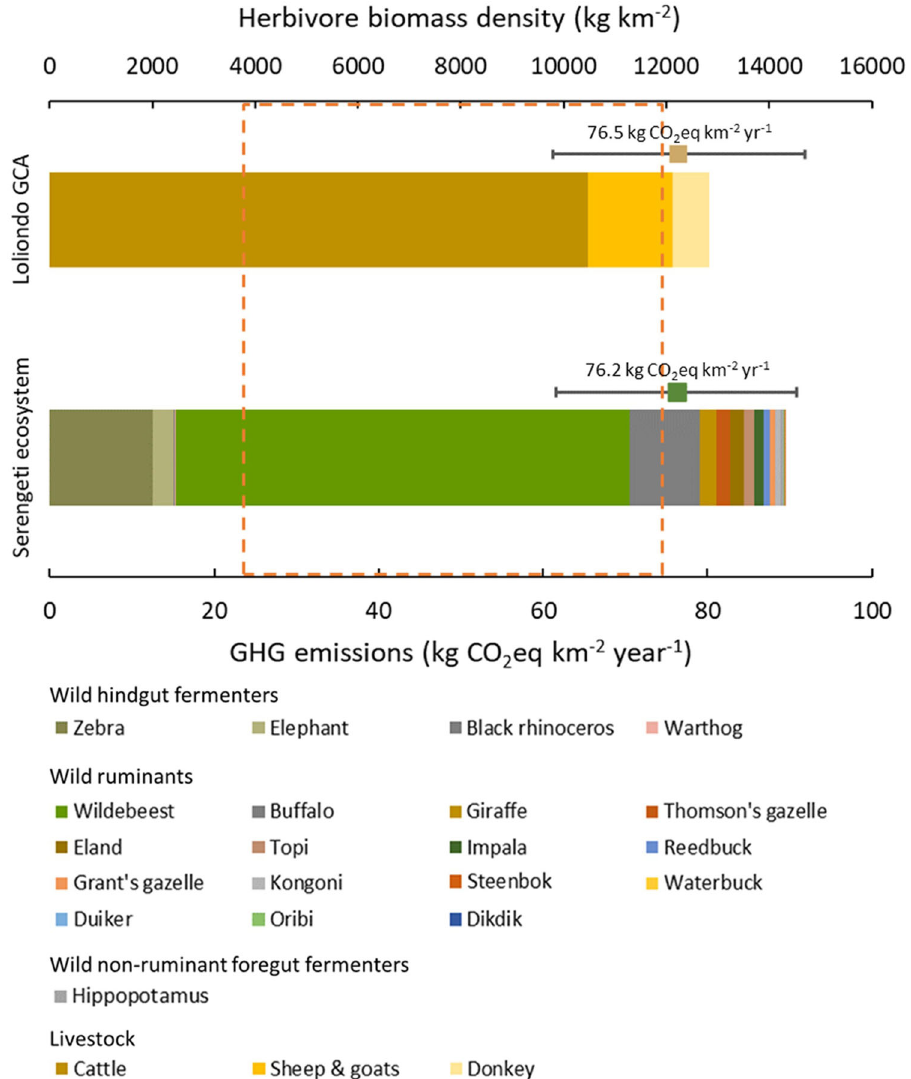
Fig. 2 Herbivore biomass density and GHG emissions per area in wildlife-dominated Serengeti ecosystem and pastoralism-dominated Loliondo GCA. Points and error bars indicate the average and standard deviation of GHG emissions computed by applying fi ve different estimation methods 13,14 (IPCC Tiers 1, 2a, and 2b, as well as allometric 1 and 2). GHG calculations include CH 4 from enteric fermentation, and CH 4 as well as N 2 O from manure deposition in pasture. Stacked bars indicate the biomass density of large herbivores present in the area. The orange box indicates the estimated range ( fi rst and third quartiles) of herbivore biomass density in Africa across medium-productivity ecosystems 9